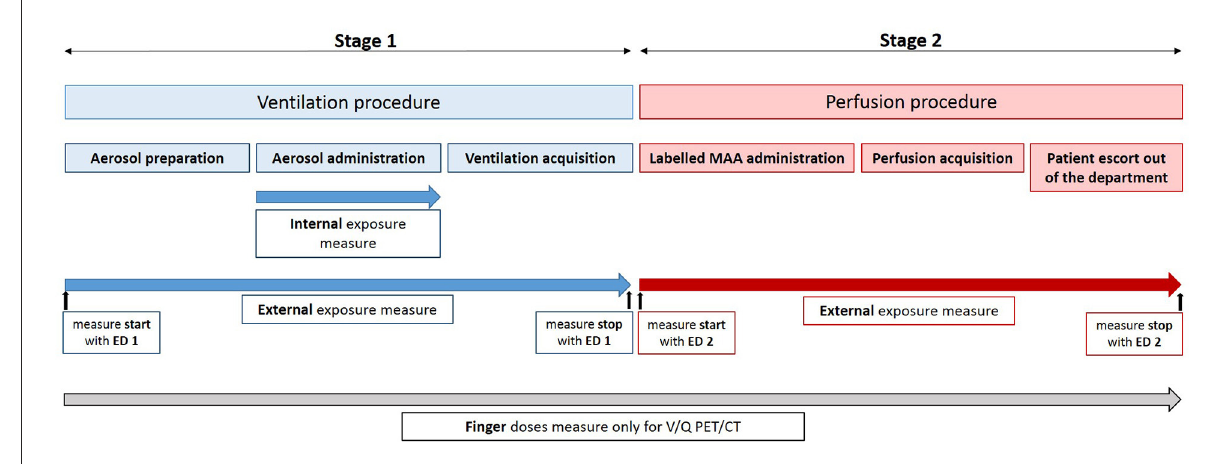
FIGURE1 Summary of doses measurements for V/Q procedures: PET/CT and